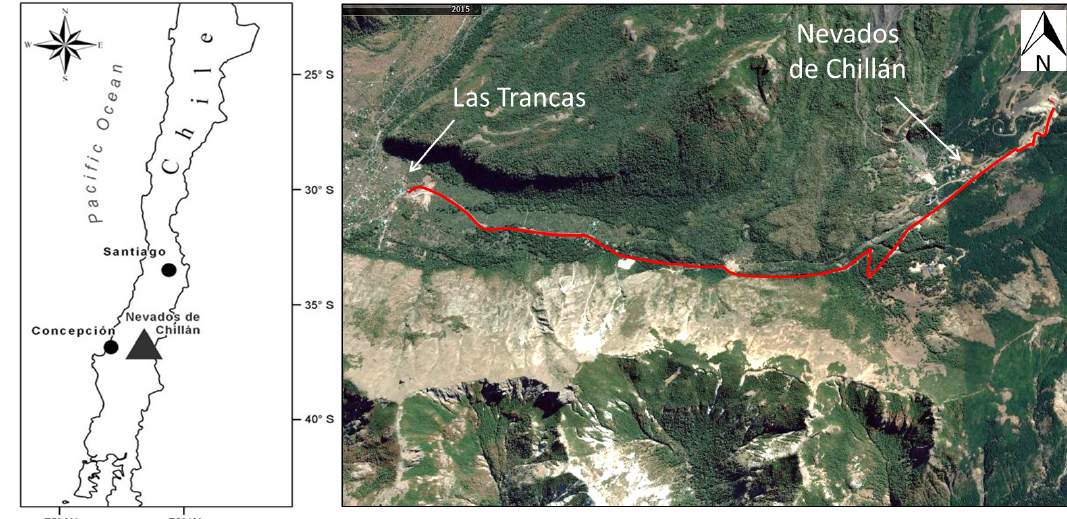
Figure 1. Study area. We focused our studies on natural hazards and protection forest along the road (red line) connecting Las Trancas with Nevados de Chillán. The north-facing slope adjacent to the road is much less vegetated compared to the south-facing slope, which is mostly explained by the lower radiation received on the latter and thus longer remaining snow cover that provides water in drier periods of the year (see also Fig.